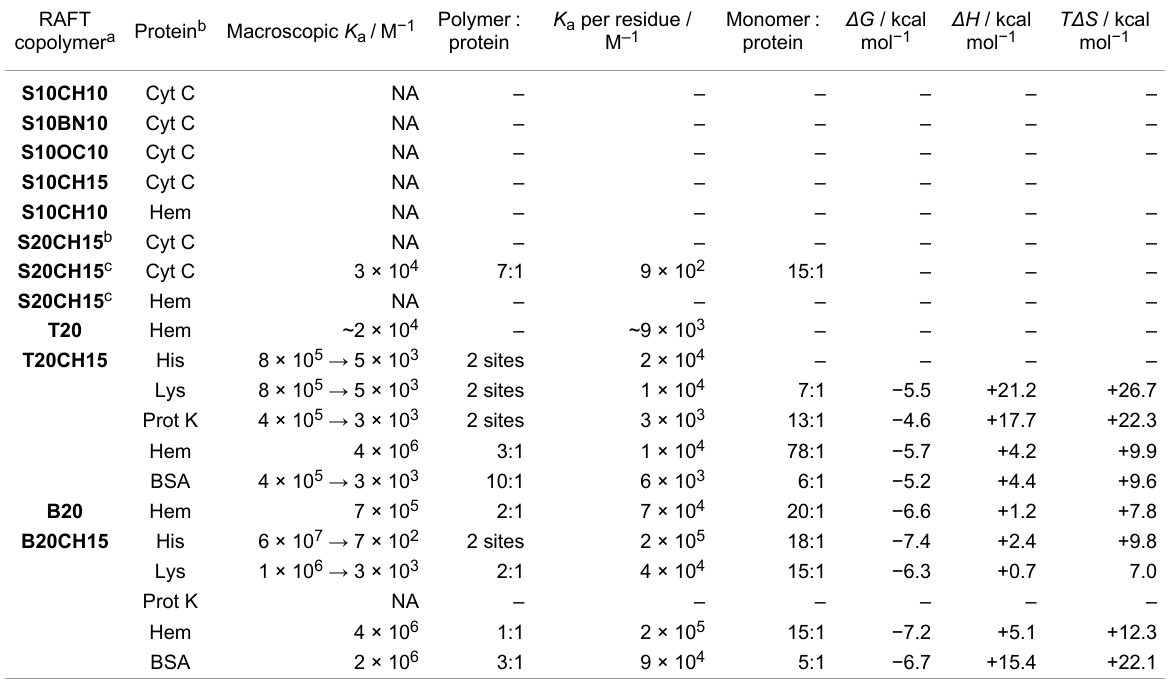
Table 2: Microcalorimetric protein titrations with RAFT polymers. RAFT Protein b Macroscopic K a / M − 1 copolymer a